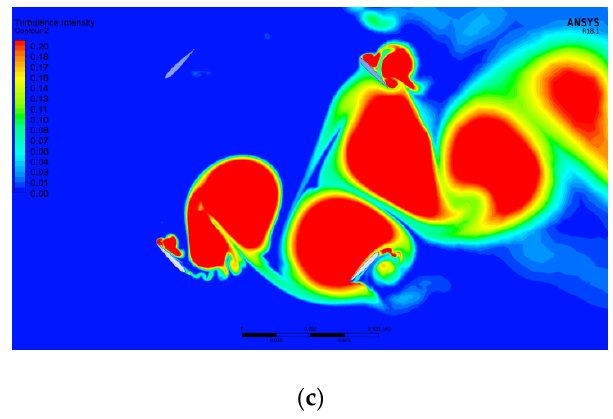
Figure 12. Contours of turbulent intensity for DDES ( a ), RANS Transition ( b ) and RANS SST k-ω ( c ) at 45° azimuthal position at λ max = 0.29.